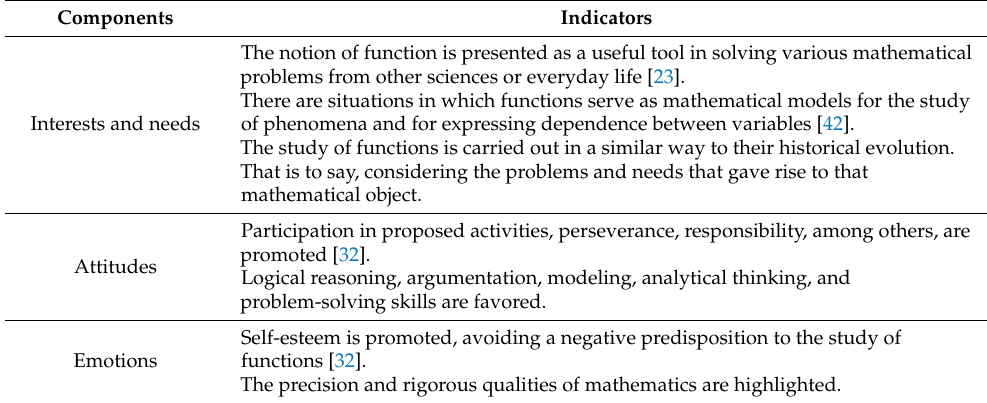
Table 3. Affective suitability for teaching